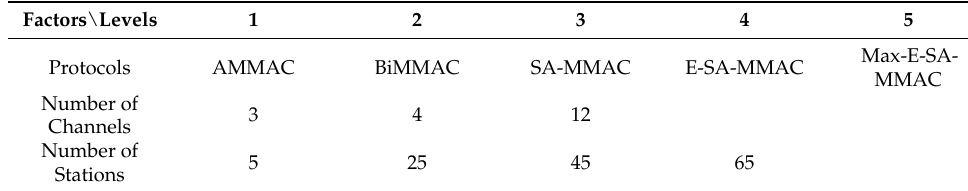
Table 5. Factors and levels for MMAC performance